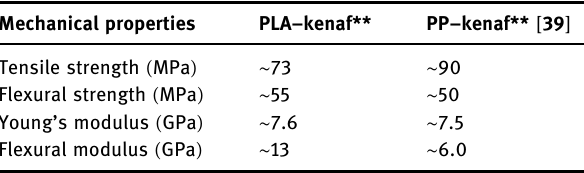
Table 2: Comparison of mechanical properties of fabricated PLA – kenaf and PP – kenaf composites using the hot press method at